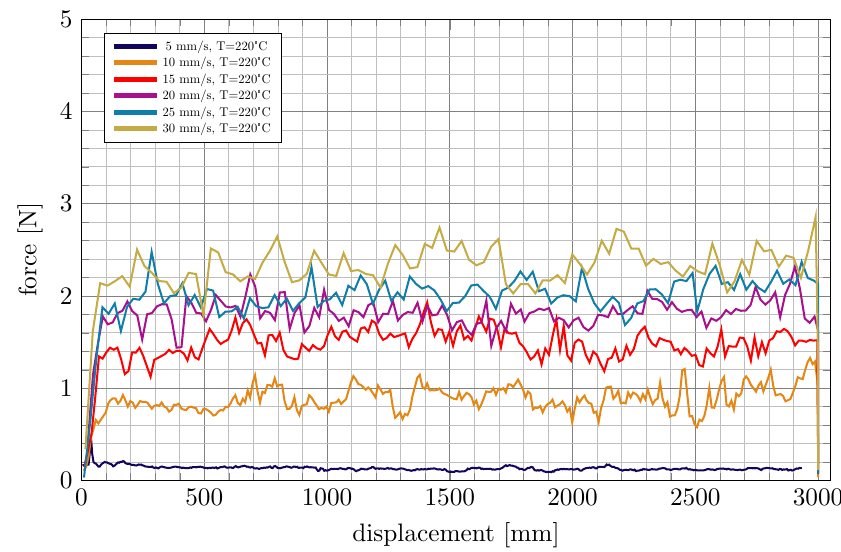
Figure 10. Deforming forces of GF-PP at 220°C and D fe =